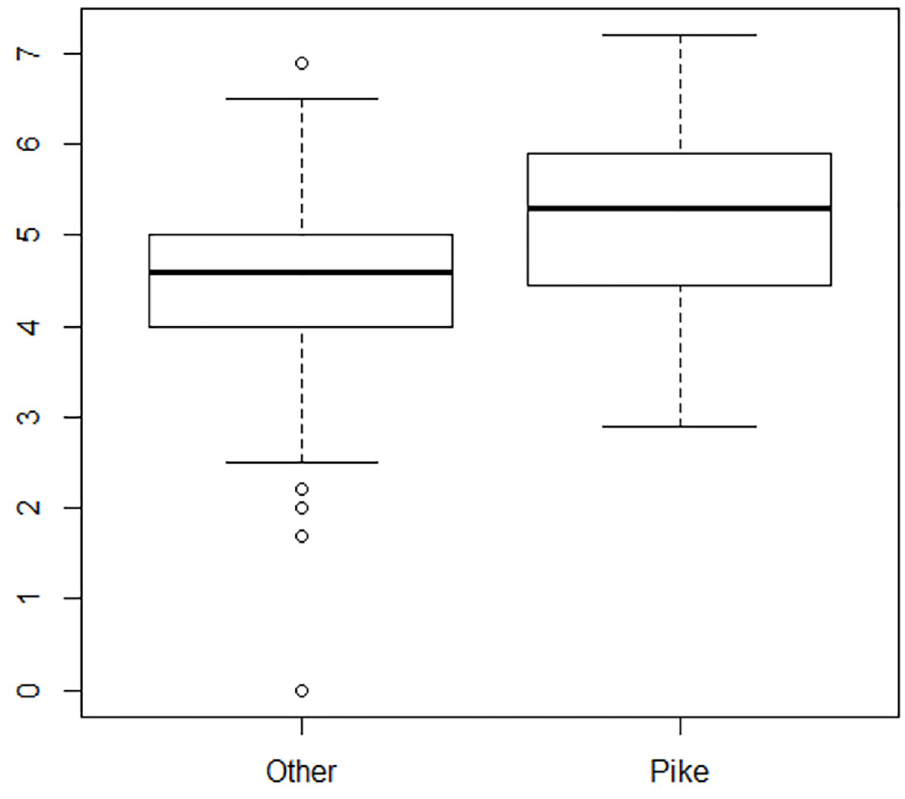
Fig 5. Distribution of mean scores of pike position vs. other positions. Box plots showing the distribution of mean scores once the positions free, straight, and tuck have been collapsed into the category of other.